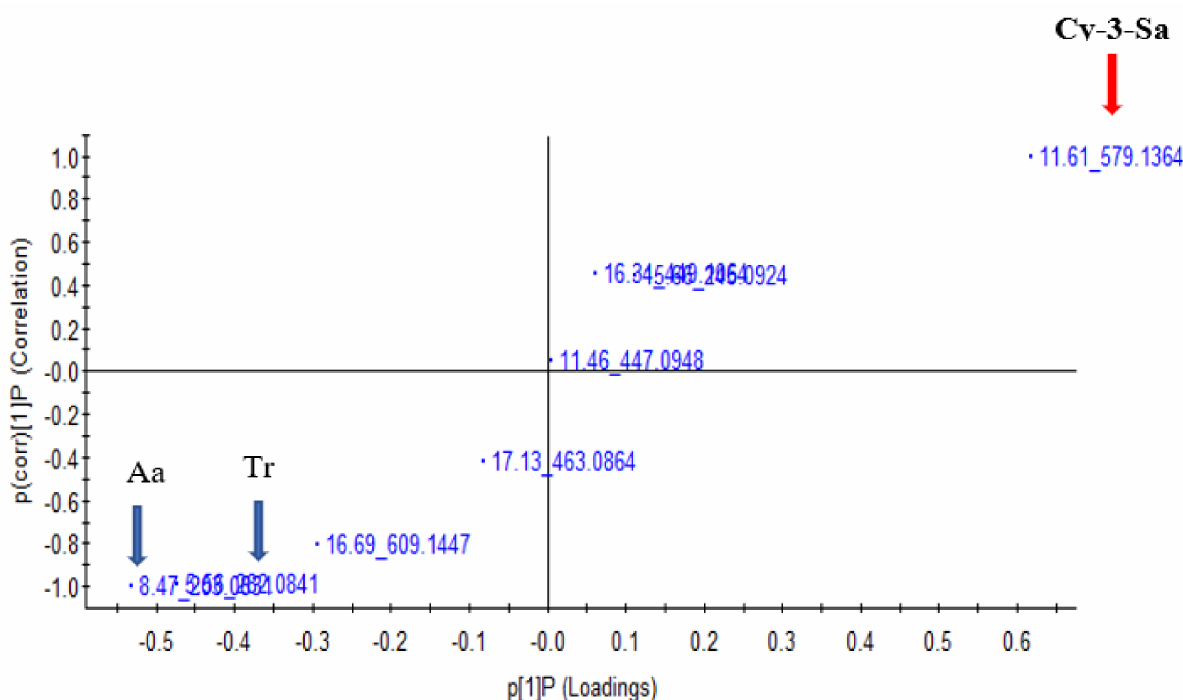
Figure 2. Score plot of orthogonal partial least squares discriminant analysis of UPLC–Q-TOF/MS spectra of digested Natal plum freeze-dried powder in the gastric and intestinal fractions. Each sample set includes three replicates: Cyanidin sambubioside ( m / z 579.13, retention time 11.61); Aa-amino acid derivative; ( m / z ) 203.08, retention time 8.47); and tryptophan ( m / z ) 282.08, retention time